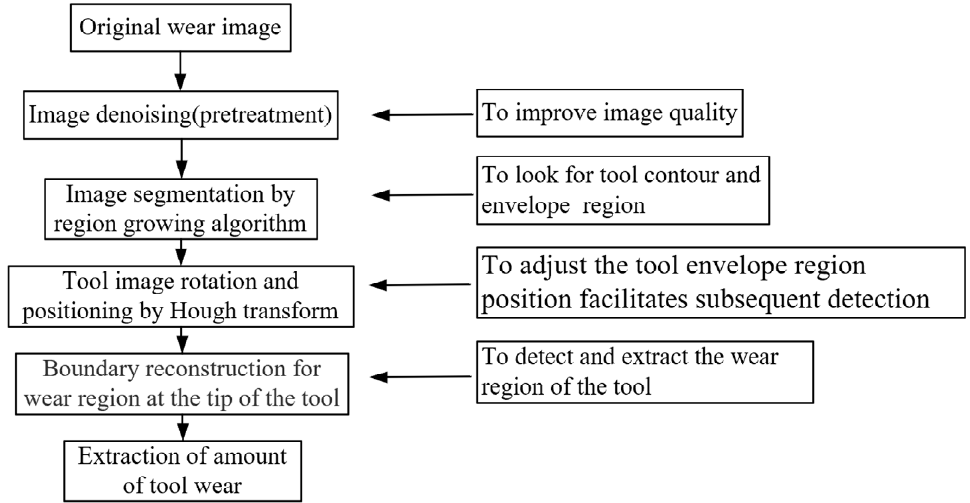
Figure 7. Flow chart of tool wear image processing algorithm of micro end milling cutter.